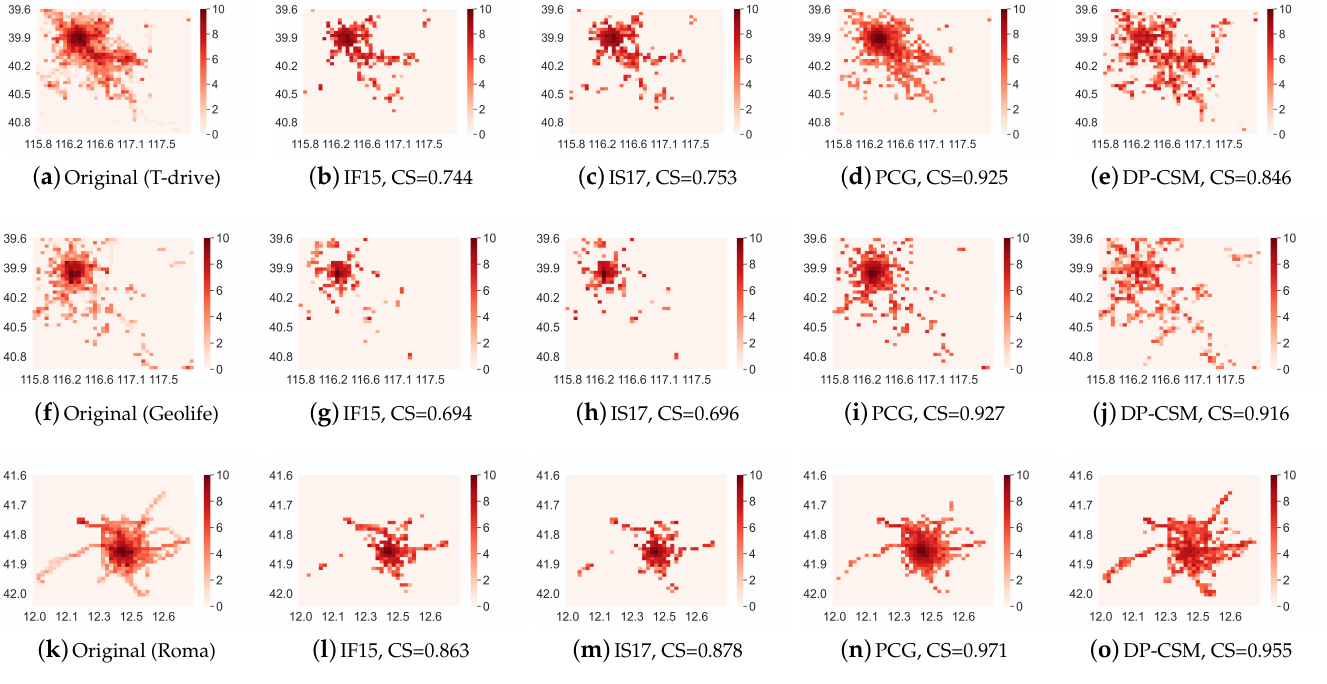
Figure 4. Heatmap of raw trajectory databases and sanitized trajectory datasets resulting from the four methods. All the sanitized trajectory datasets were generated under the following parameters setting: (cid:101) = 0.4, k = 80, |D| = 12,000. ( a – e ) are results on T-drive, ( f – j ) are results on Geolife and ( k – o ) are results on Roma. For each figure, the x-axis represents the longitude, the y-axis represents the latitude. The CS in captions of sub-figures stands for the cosine similarity between the heatmap per se and its corresponding raw dataset’s